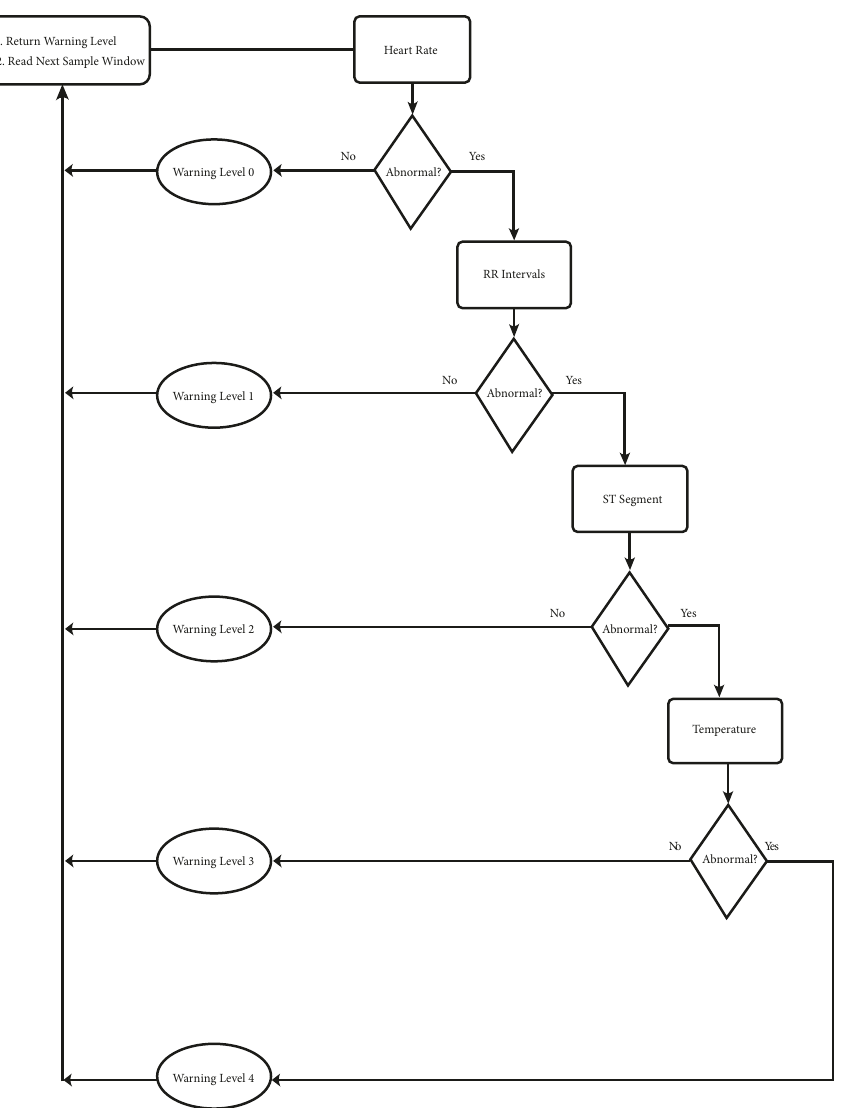
Figure 14: Flow diagram of decision tree